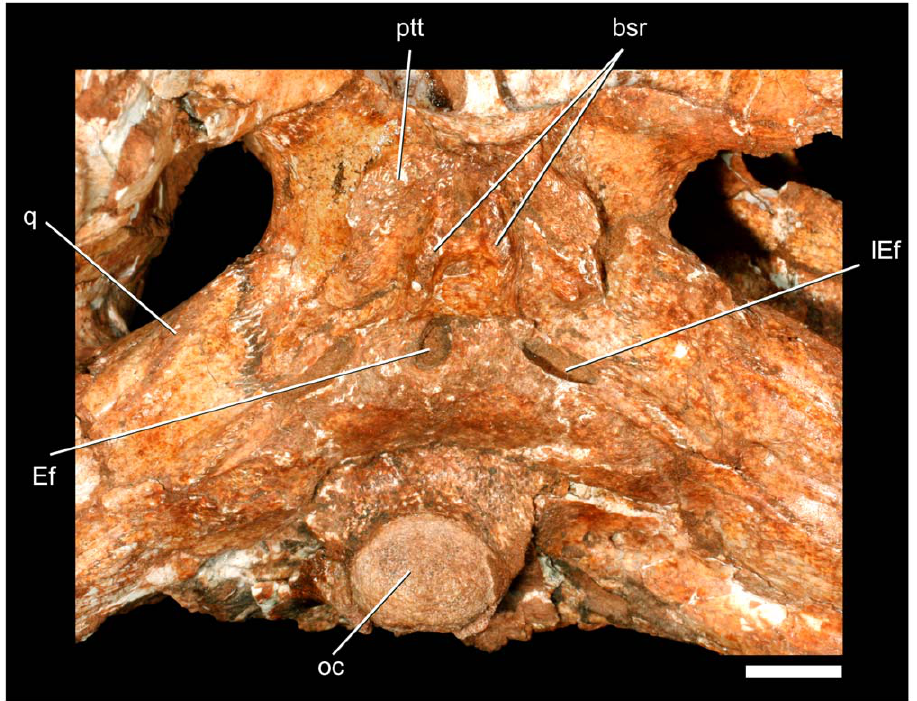
Figure 15. Details of the ventral portion of neurocranium of Pissarrachampsasera (LPRP/USP 0019). Abbreviations: bsr, basisphenoid ridges; ptt, pterygoid tuberosity. Scale bar equals 1 cm. doi:10.1371/journal.pone.0021916.g015 the mandibular condyle. In lateral view, this extension forms a small notch at the level of quadratojugal-quadrate contact (Figure 14). A lateral depression on the quadrate body extends onto the ventral portion of the quadratojugal-quadrate suture. The medial surface of the quadratojugal has long dorsal process, which prevents the contact between quadrate and postorbital, and reaches the ventral edge of the internal supratemporal fenestra.